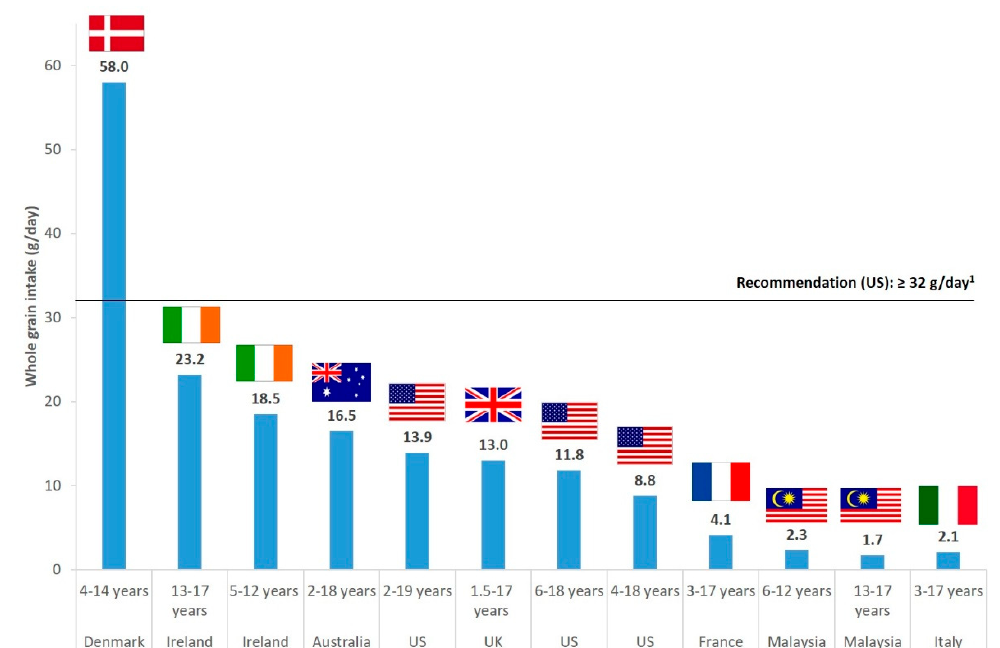
Figure 1. Whole grain daily intakes in children and adolescents in several countries as reported by nationally representative dietary surveys. Reported intakes are expressed in grams of whole grain ingredients and correspond to mean intakes in all cases, except for Australia and the United Kingdom (UK) where medians are reported. 1 Recommendation for whole grain consumption for children aged 3–7 years, as reported in the Dietary Guidelines for Americans 2015 (see Table 1 for details; recommendations for children energy intakes from the US Institute of Medicine have been used to convert recommendations from g/2000 kcal into g/day). Sources of the reported data are as follows: